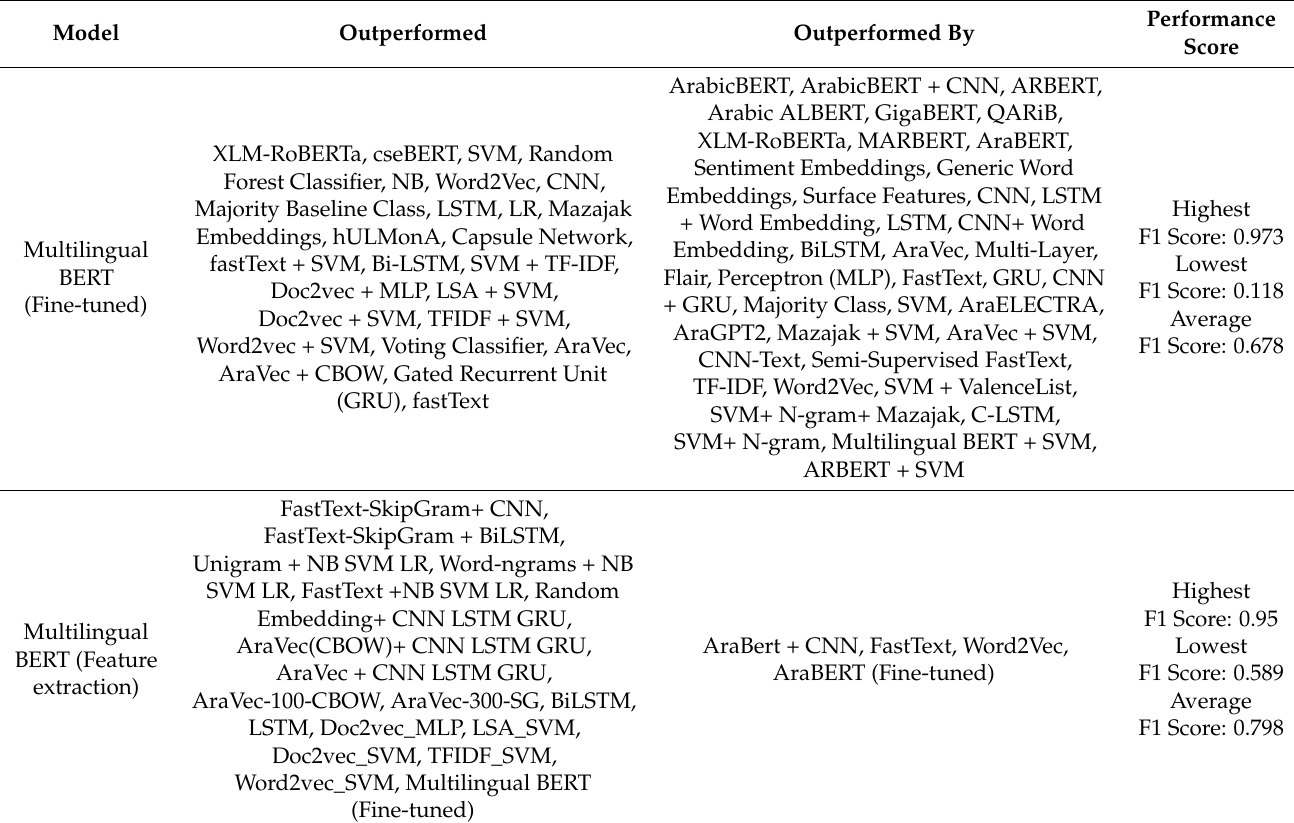
Table 5. Performance of the BERT